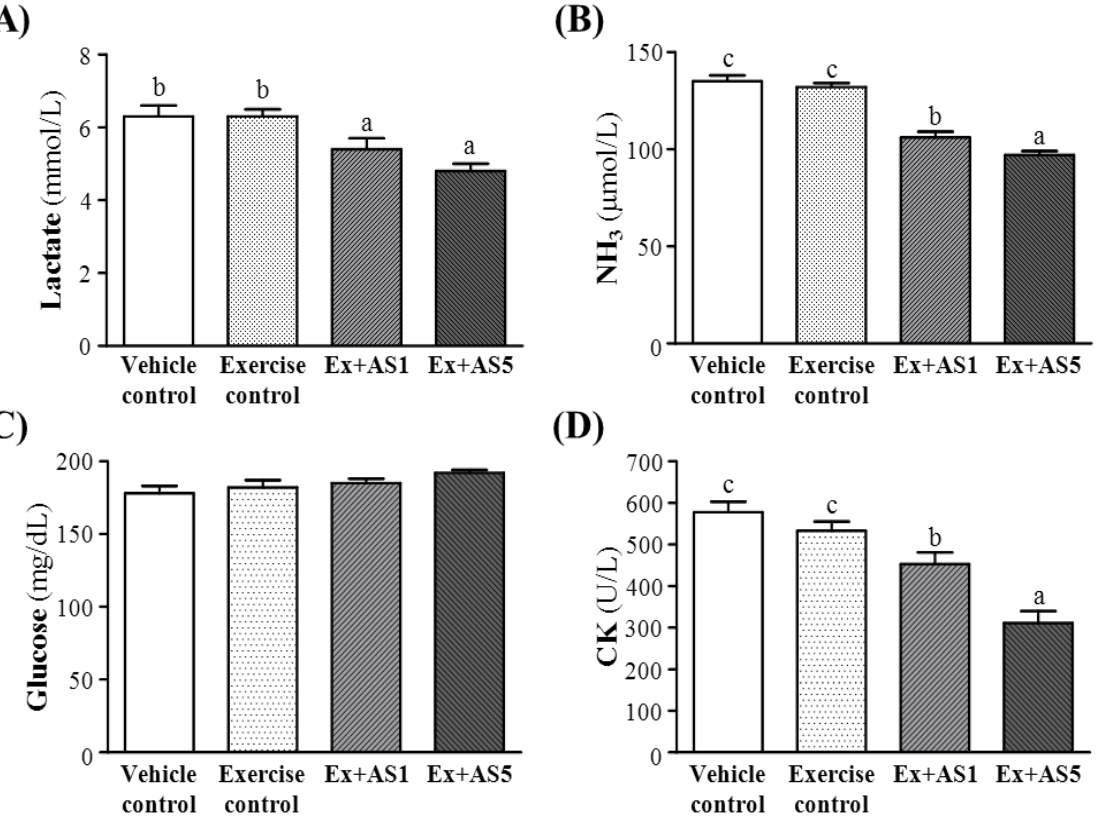
Figure 3. Effect of AS supplementation on serum lactate ( A ), ammonia ( B ), and glucose ( C ) levels and CK ( D ) activity immediately after 15-min swimming test without weight loading. Data are mean ± SEM of 10 mice in each group by one-way ANOVA. Different letters (a, b and c) indicate significant difference at p < 0.05.